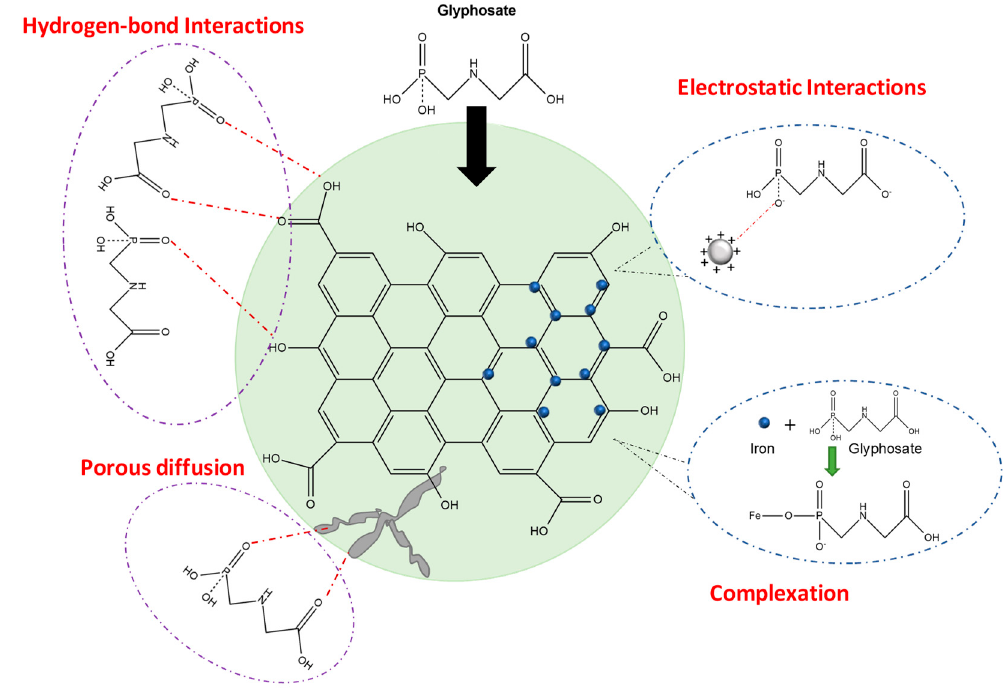
Figure 2. Glyphosate adsorption mechanism of carbon absorbents and iron-based adsorbents.